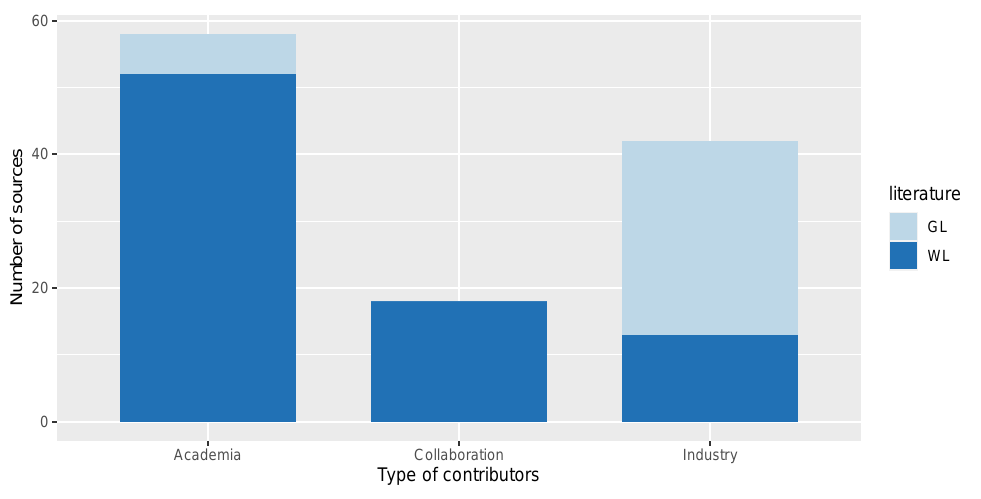
Figure 4. Affiliations of authors of white literature sources.